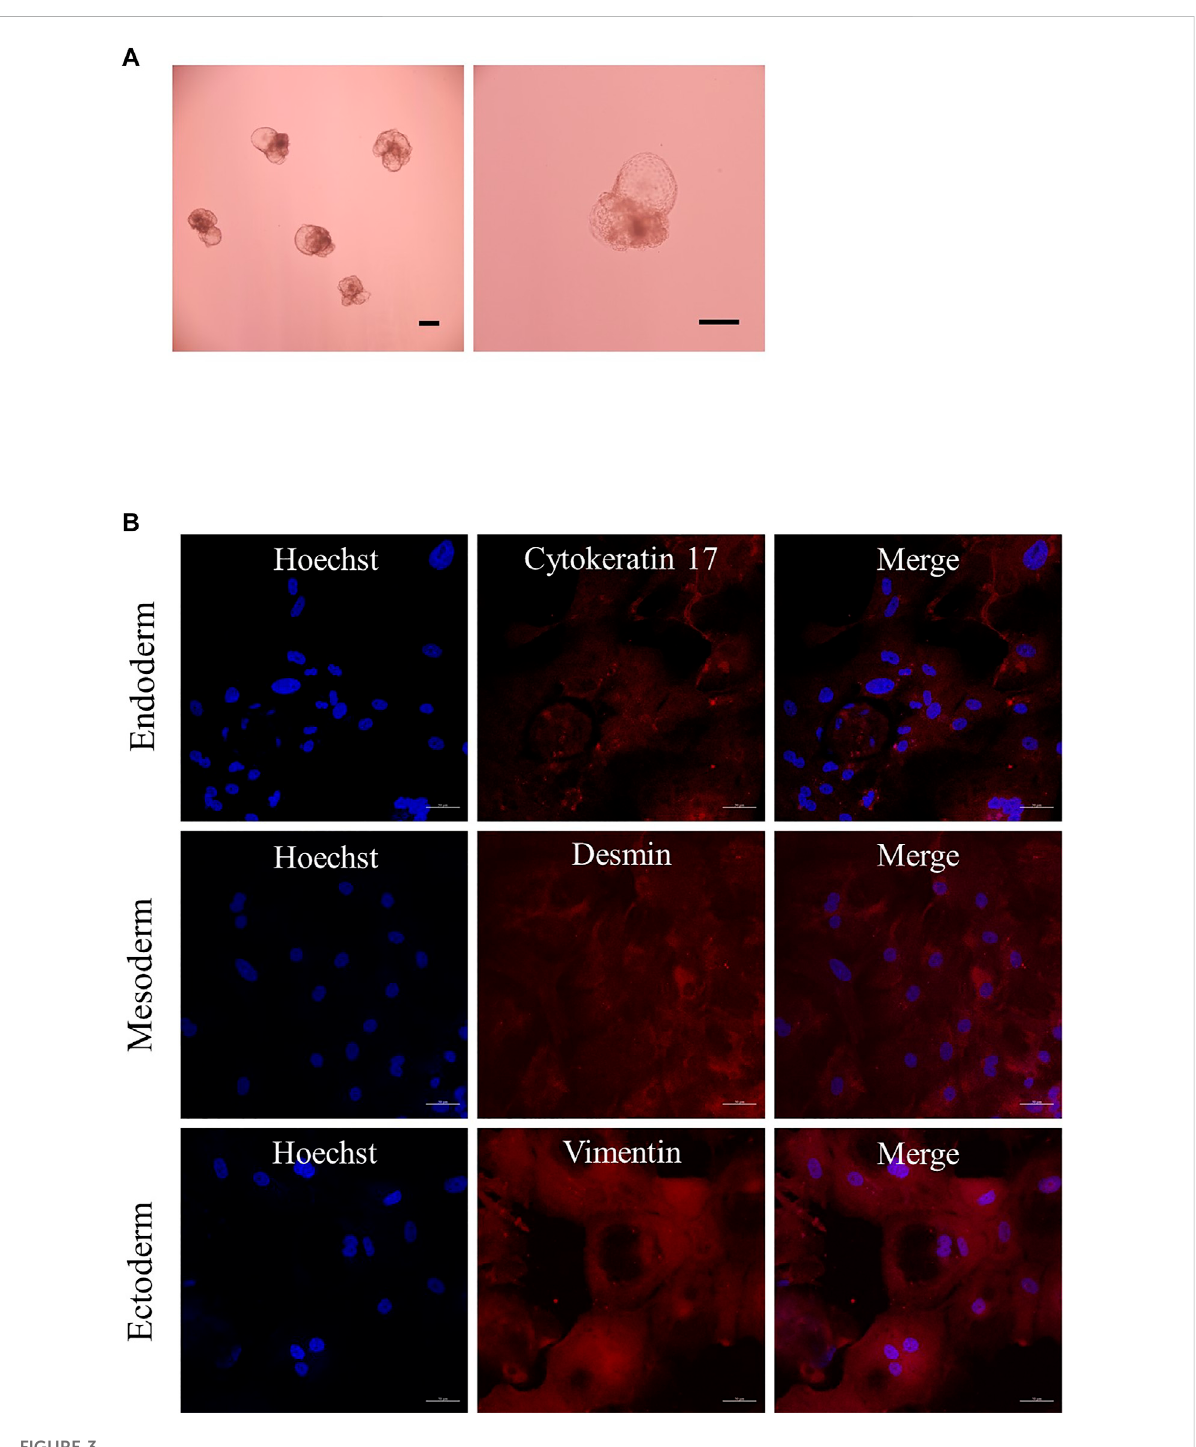
FIGURE 3 Expression ofdifferentiationinembryoidbodies(EBs). (A) EBsderived fromporcineembryostem-likecells withPHA-L.Scalebar=200 μ m. (B) Expression of differentiation markers cytokeratin 17 (endoderm), desmin (mesoderm), and vimentin (ectoderm) from EBs by immuno fl uorescence analysis. Nuclei and differentiation markers are shown in blue and red, respectively. Scale bar = 50 μ